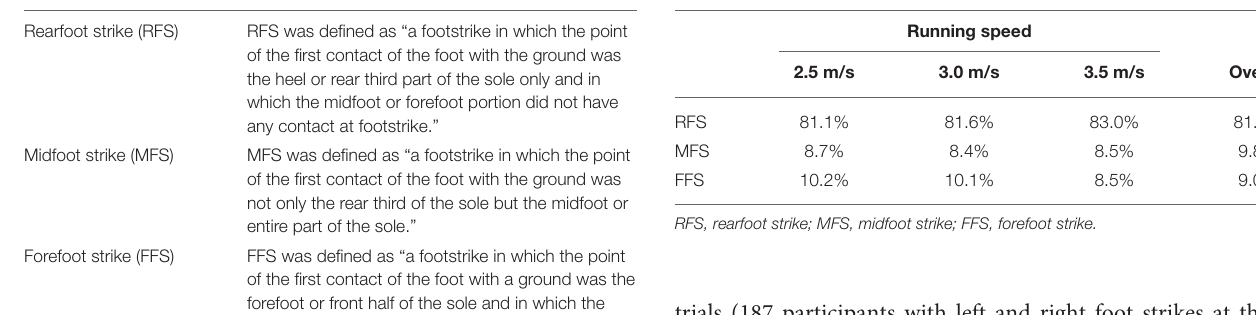
TABLE 1 | Foot strike definitions taken from Hasegawa et al. (2007). TABLE 2 | Participant foot strike patterns by percentage across running